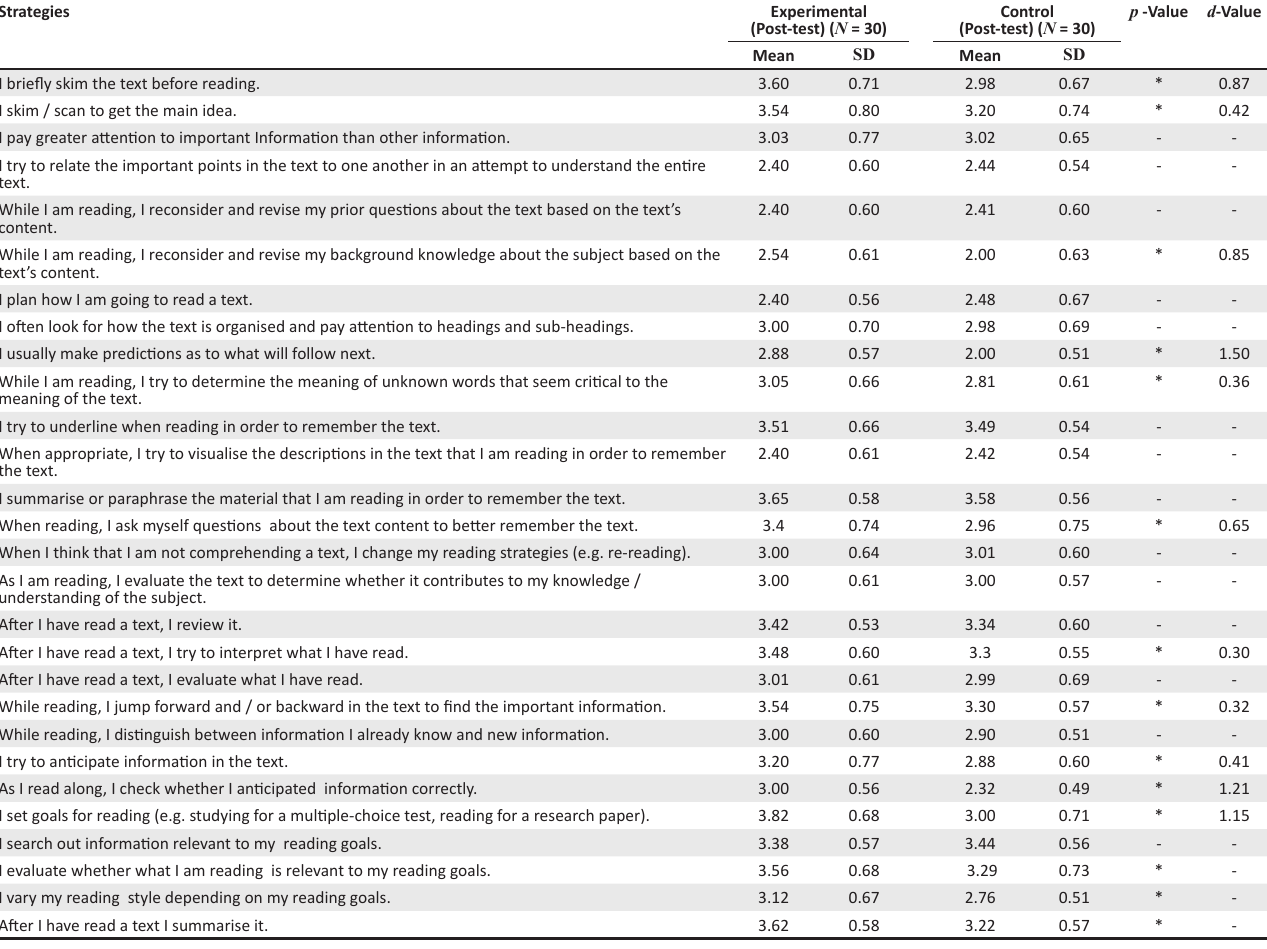
TABLE 2: The post-test reading strategy use profile of Grade 11 ESL learners: Experimental group versus control group. Strategies